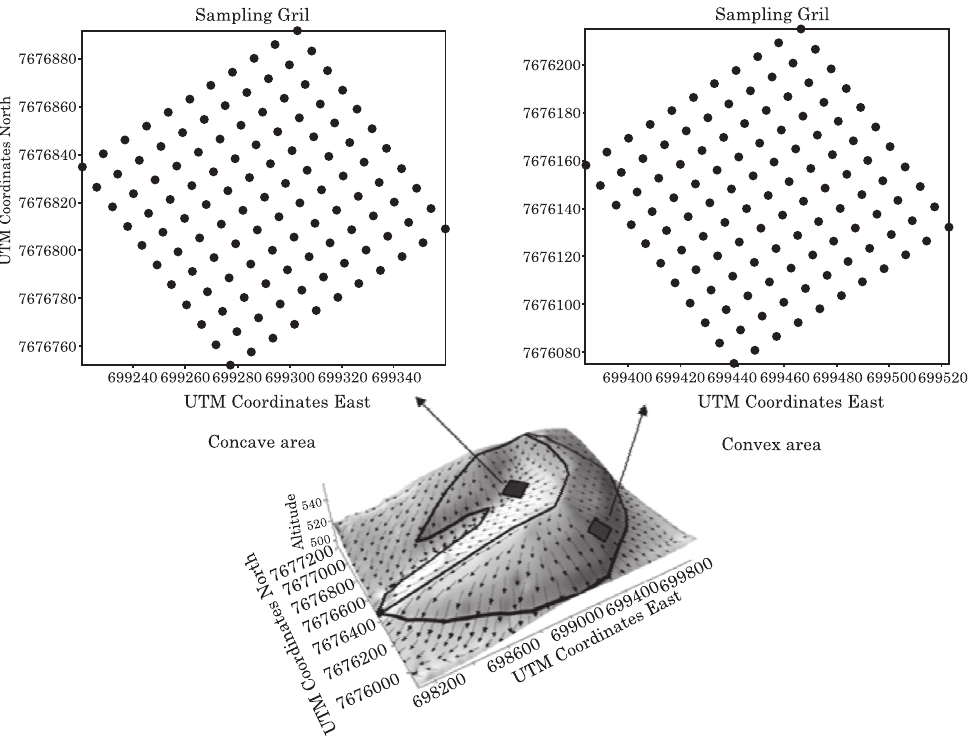
Figure 1. Digital elevation model (DEM) for the study area and sampling sites (+). The arrows in the center represent surface water flow.